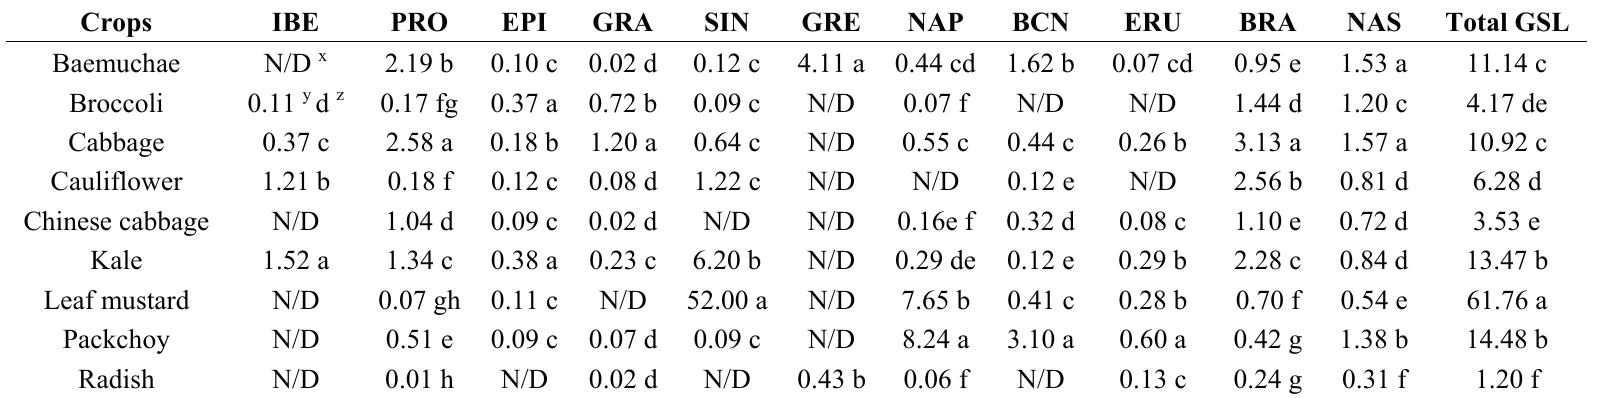
Table 4. Glucosinolate concentration (µmol·g − 1 dry weight) in shoot of nine Brassica vegetables. Crops